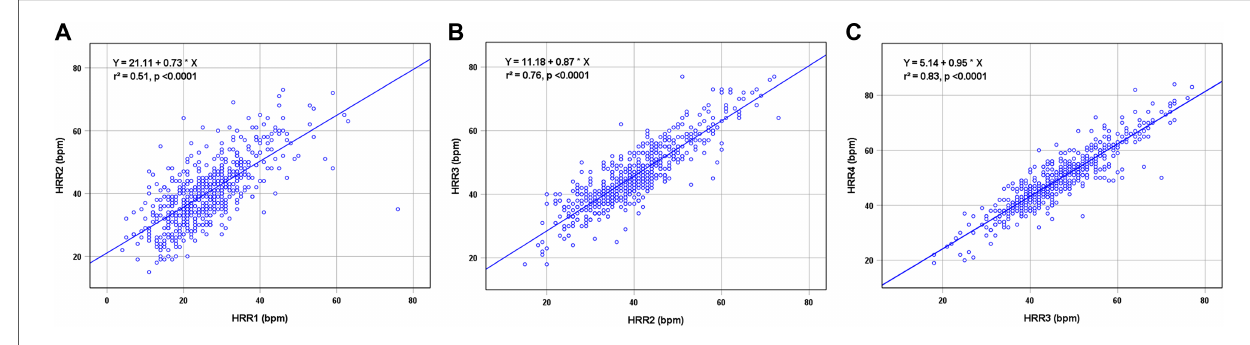
FIGURE 2 Correlations between HRR1 and HRR2 ( A ), HRR2 and HRR3 ( B ), and HRR3 and HRR4 ( C ). HRR, heart rate